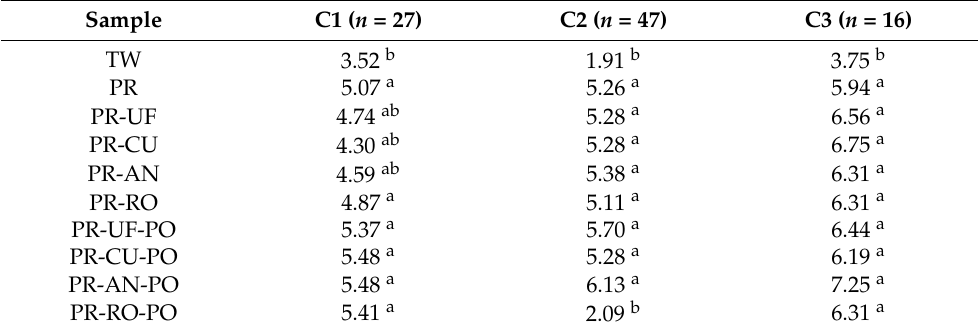
Table 3. Mean consumer acceptance ratings of purified water samples for each cluster generated by the agglomerative hierarchical cluster analysis. Sample codes refer to Figure